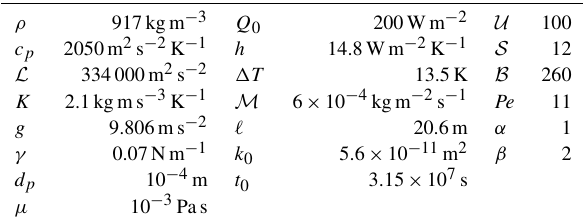
Table 1. Table of physical values, derived scales, and nondimen- sional parameter values (defined in Appendix B).